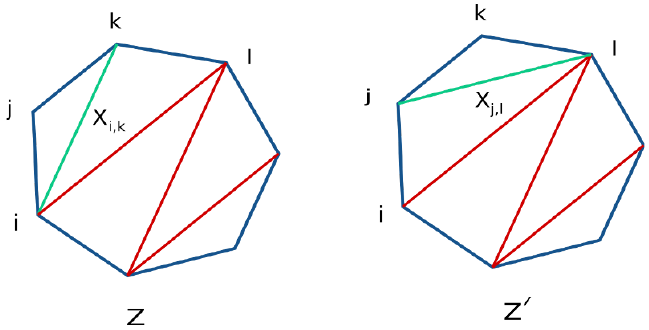
Figure 6 . Two triangulations related by mutation: X